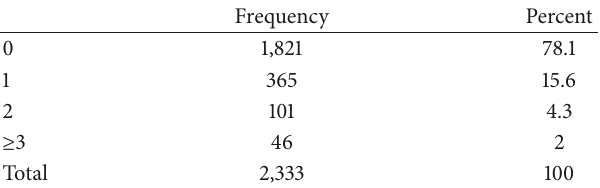
Table 3: Positive sentinel lymph nodes.